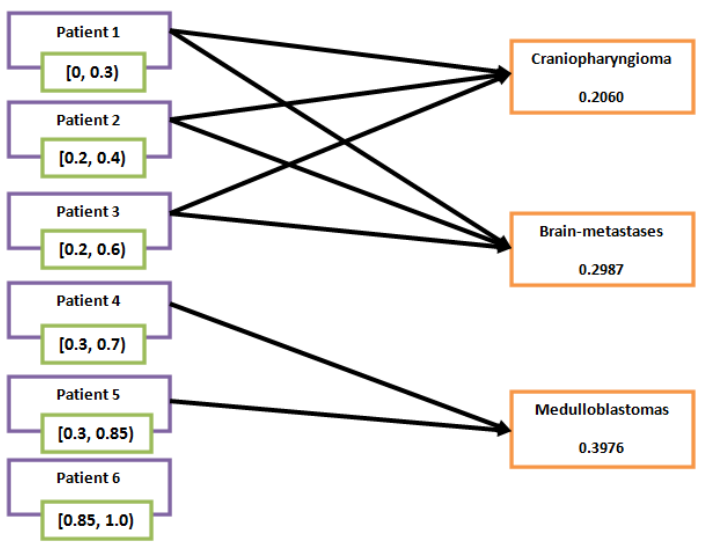
Figure 8. Relation between the patients and brain tumours.